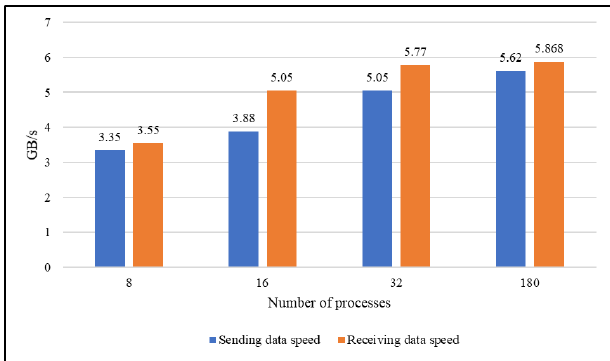
Fig. 6. maximum read or write speed of 6 FSTs in two replica